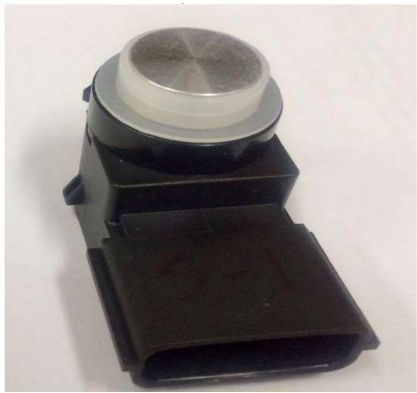
Figure 11. An actual ultrasonic sensor for in-air